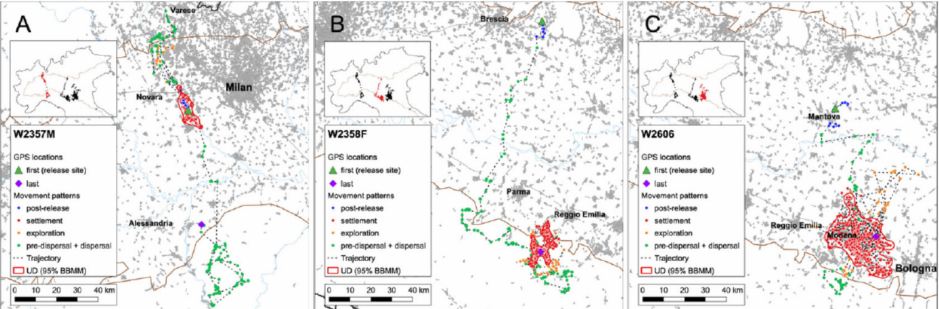
Figure 2. GPS locations obtained for three GPS-collared wolves in Northern Italy, 2019–2021. ( A ) W2357M; ( B ) W2358F; ( C ) W2606. Brown line delineates 300 m a.s.l. contour line, while ur- ban areas are in